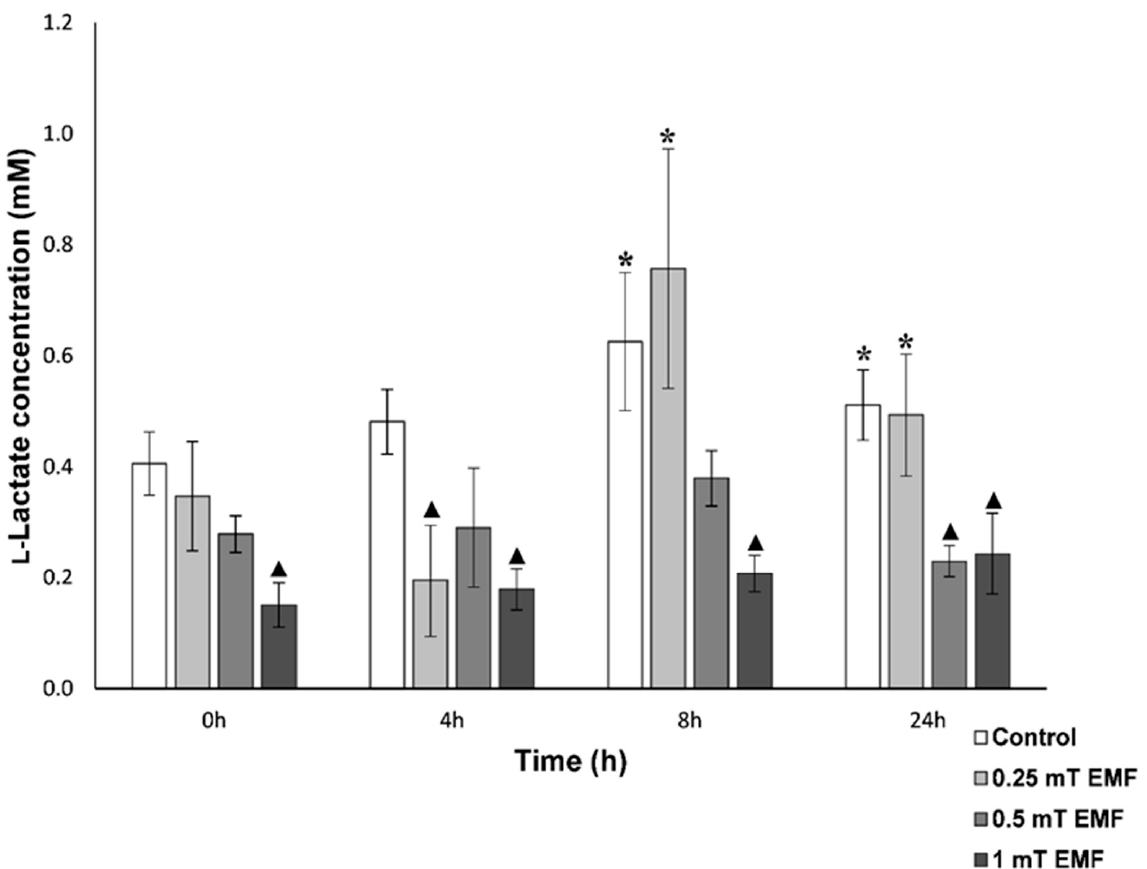
Figure 3. ʟ -Lactate concentration over a 24 h period in control conditions and exposure to EMF at 250 µT, 500 µT, 1000 µT strength. Sample times consisted of 0 h (09:00 a.m.), 4 h (13:00 p.m.), 8 h (17:00 p.m.), 24 h (09:00 a.m.). Values are presented as mean ± SEM, * is the significance from the 0 h within respective treatments, ▲ is the significance from the control group for each treatment at respective sampling times (*, p < 0.05), ( ▲ , p < 0.05). N = 10 for control and N = 10 for EMF per treatment, total N = 40 control, N = 40 EMF.